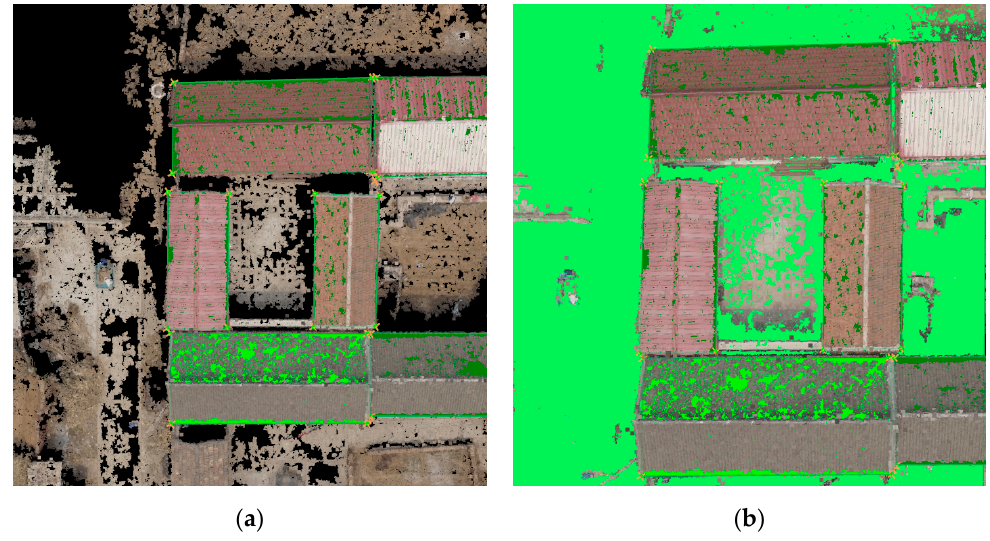
Figure 4. Images with manually drawn ( a ) upper building surfaces and ( b ) ground with a consistent level.